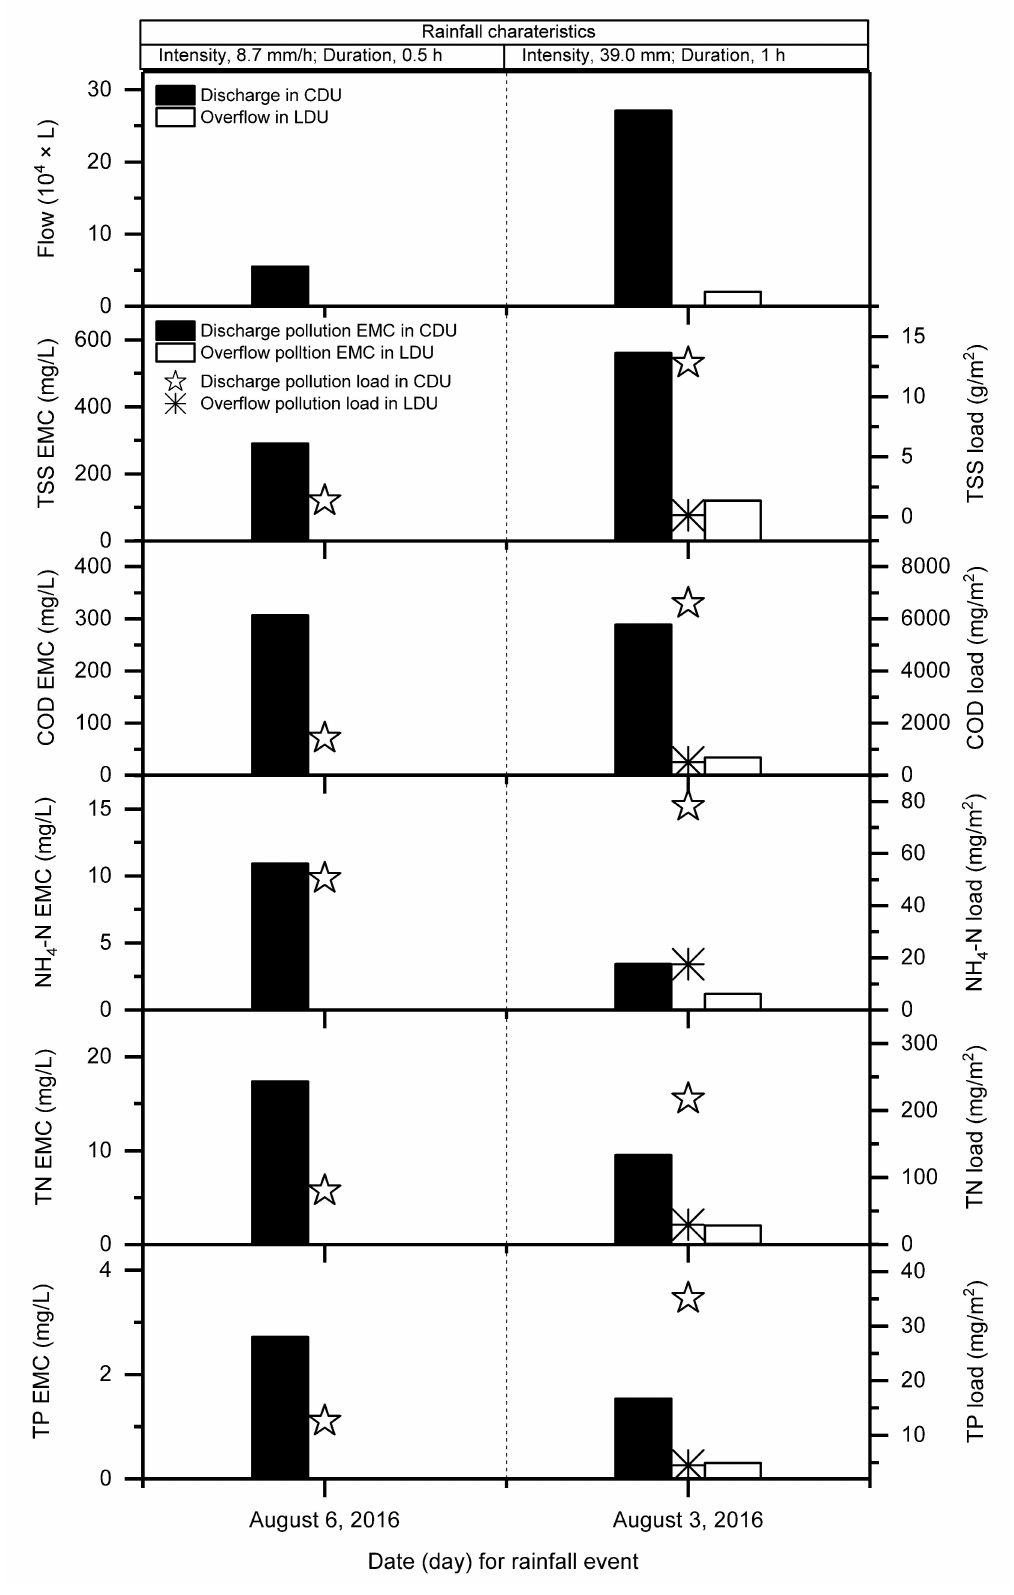
Figure 6. Role of LID practices in the reduction of runoff volume, pollutants concentration, and load at the drainage unit scale. LDU = LID residential drainage unit; CDU = conventional residential drainage